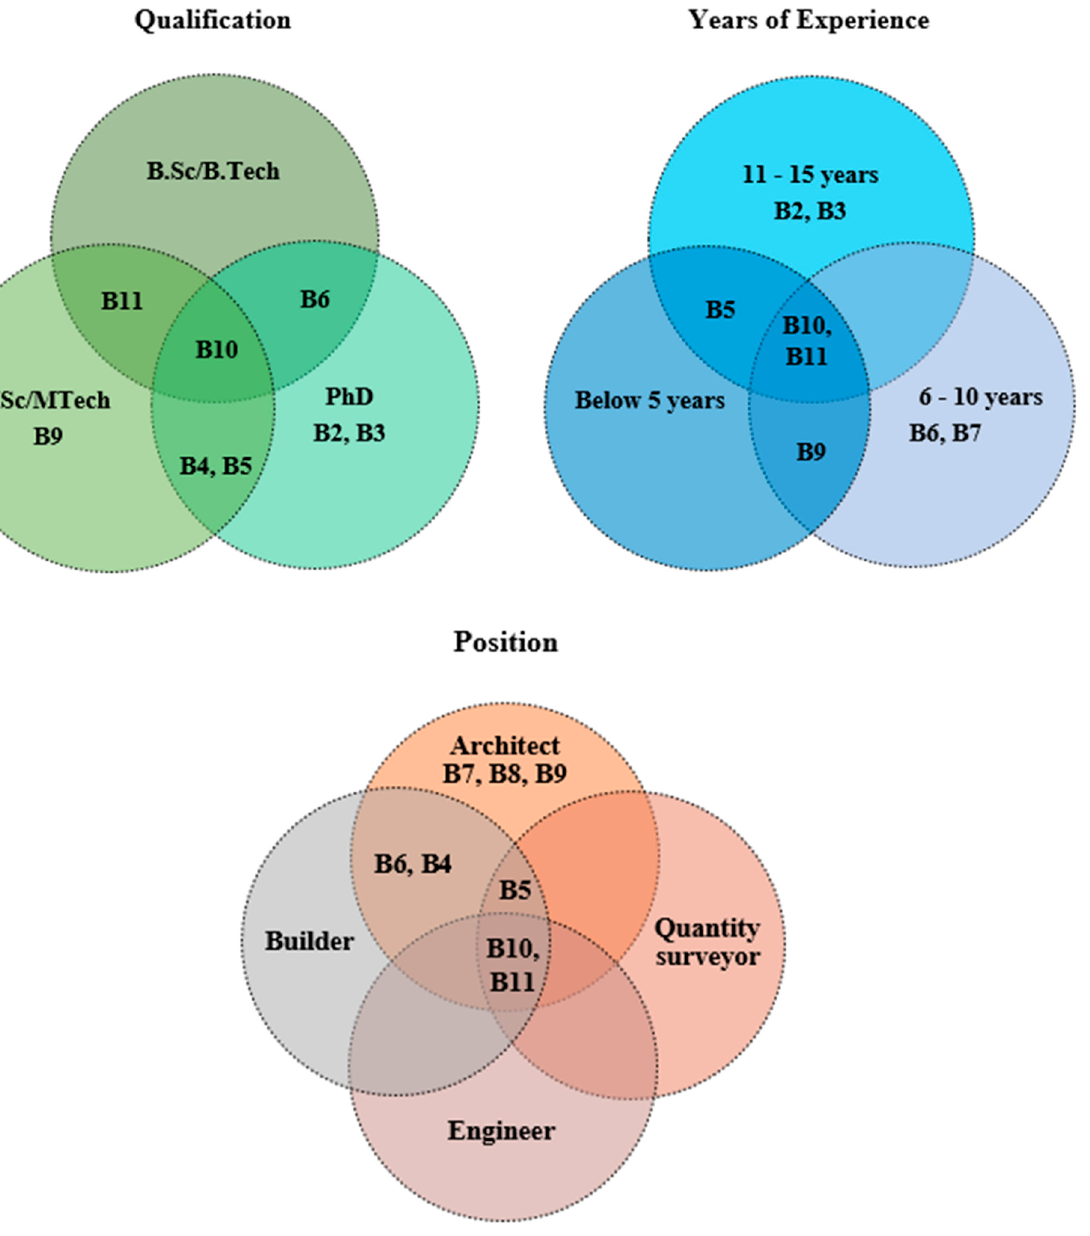
Figure 2. Findings of the overlapping analysis. Notes: B2 = security; B3 = trust; B04 = awareness; B05 = lack of technical knowledge; B06 = lack of financial strength; B09 = operational cost; B10 = connectivity problems; B11 = limited internet access.